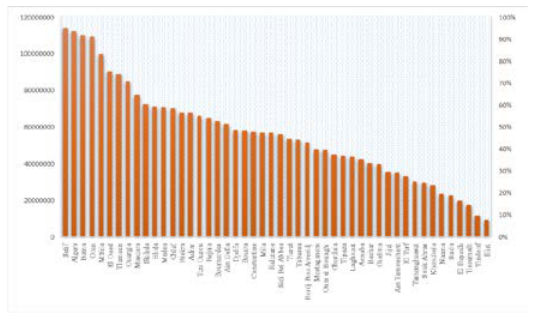
Figure 9. Sum of light in Algerian provinces in this last twenty years.